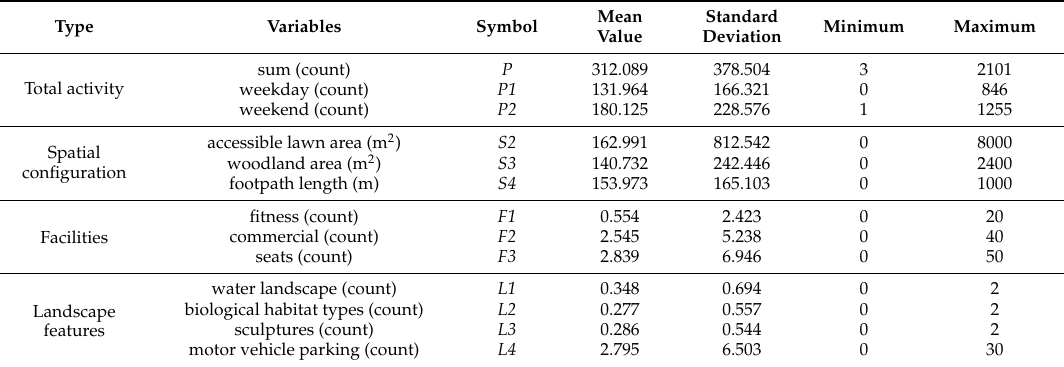
Table 2. Basic information of all variables involved.